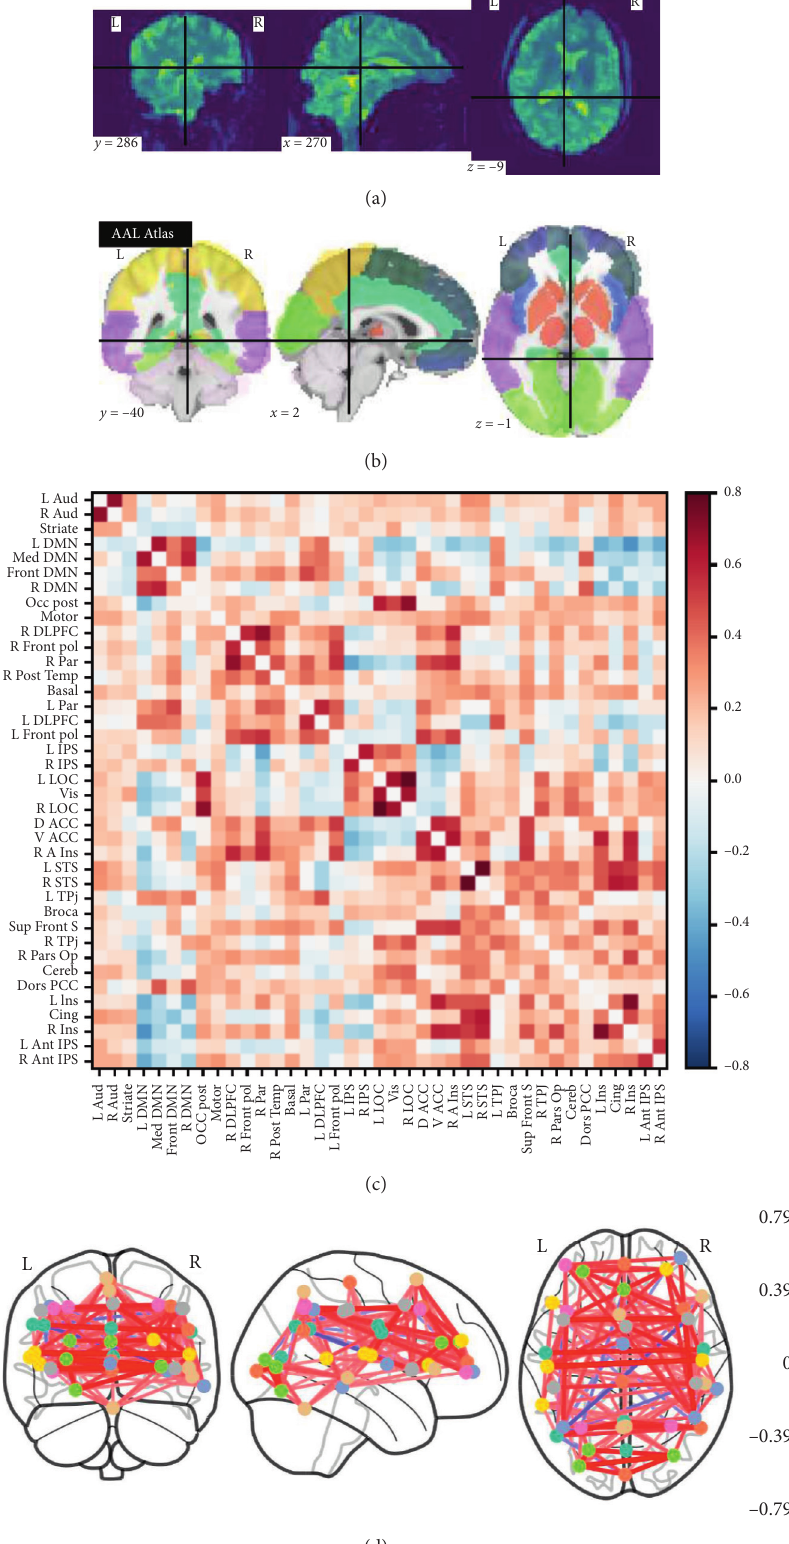
Figure 2: An example of a functional brain network. (a) Original rs-fMRI images. (b) The AAL Atlas. (c) Generated graph matrix. (d) Generated functional brain